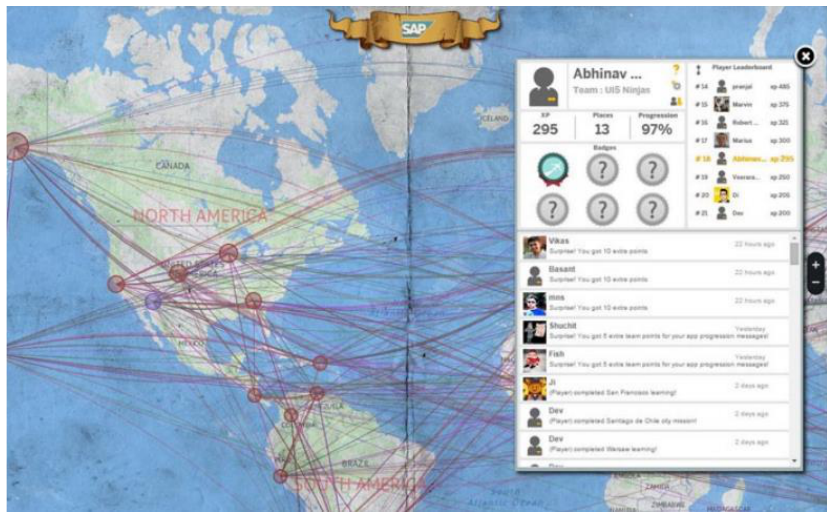
Fig. 1. Screenshot of the user interface of G-learning